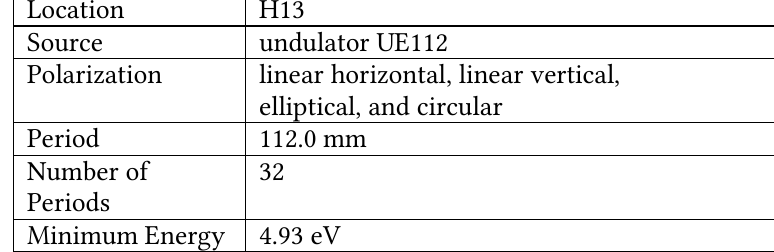
Table 1: Information summary on the insertion device